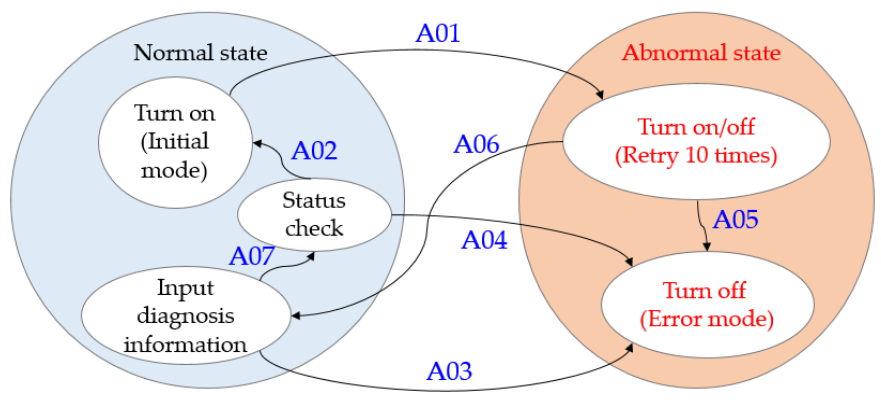
Figure 8. Flow chart of the software.